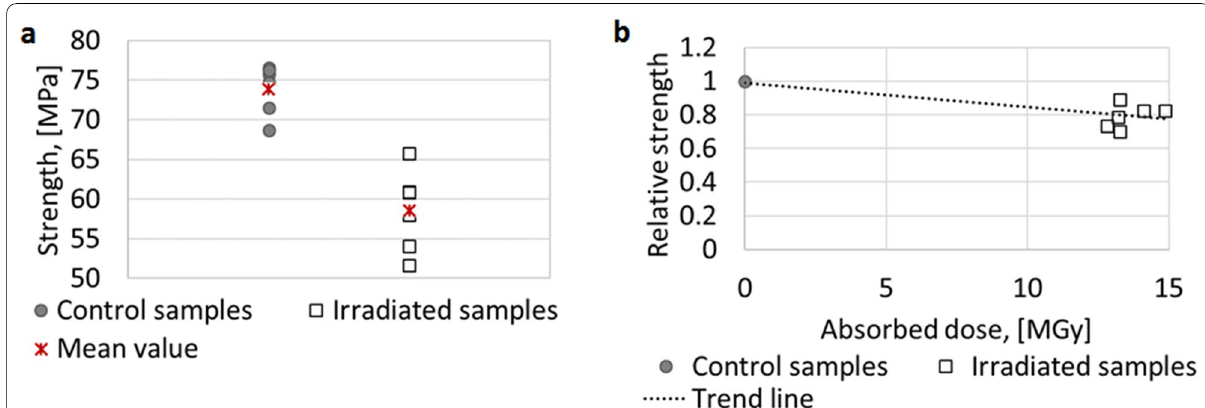
Fig. 1 Compressive strength of cement mortar samples (Khmurovska, 2019b): a in MPa, b relative in dependence on absorbed irradiation